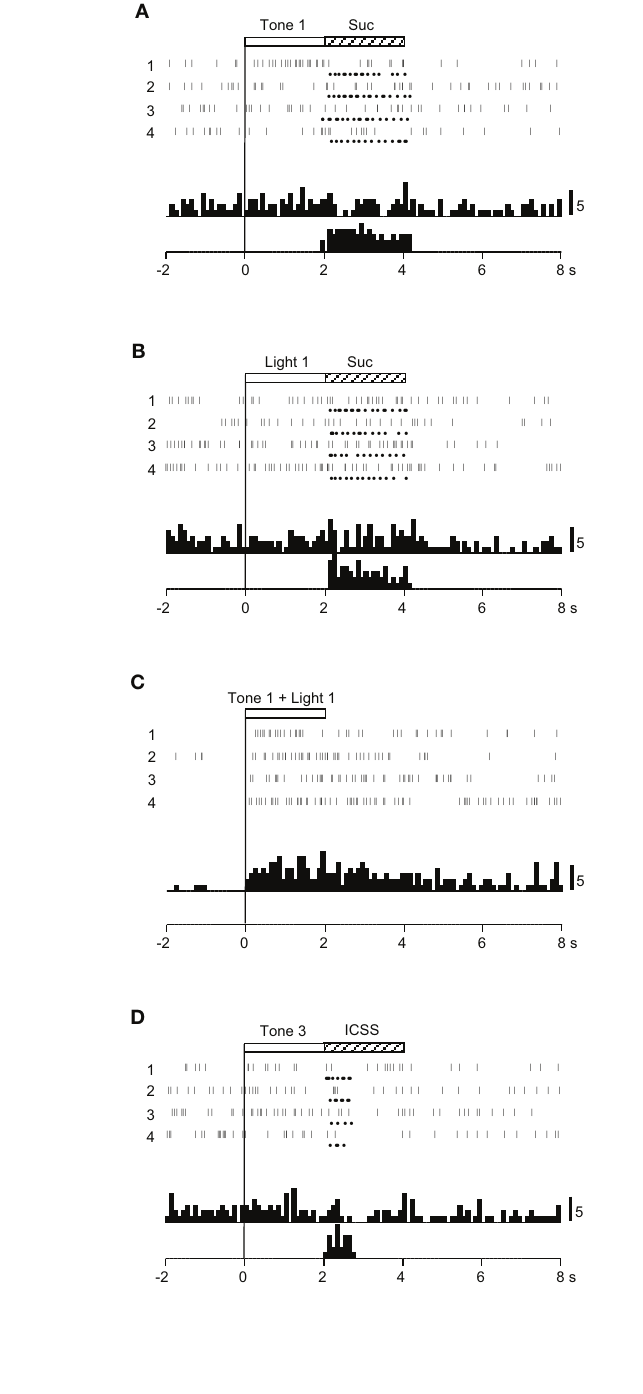
Figure 3 | Activity of a conditioned stimulus predicting non-reward (CS 0 )-related neuron that responded differently to the conditioned sensory stimuli predicting non-reward. (A–g) Raster displays and histograms of neuronal responses to Tone 1 predicting sucrose solution (A) , Light 1 predicting sucrose solution (B) , Tone 1 + Light 1 predicting non-reward (C) , Tone 3 predicting intracranial self-stimulation (ICSS) (D) , Tone 2 predicting non-reward (e) , Light 2